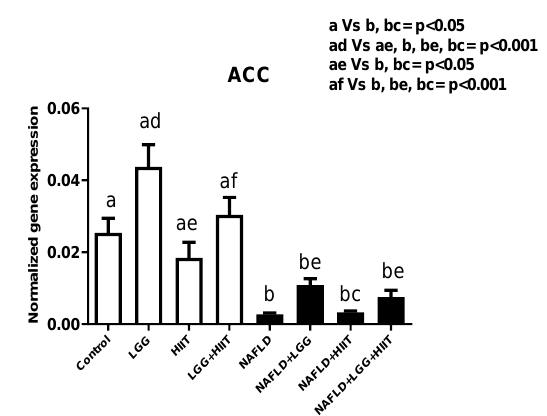
Figure 7: Liver tissue acetyl-CoA carboxylase ( ACC ) mRNA expression in different groups of study. All values are the mean ± SD (n = 10 per group). Values with different superscripts are sig- nificantly different, p < 0.05. LGG: Probiotic